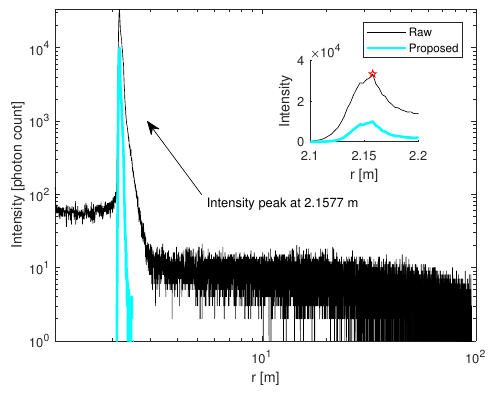
Figure 3. Short range detection results. Distribution of range observations r i from one channel, n = 127 , when sampling n over time in nominal conditions. Raw data from the single photon lidar (black) is filtered from outliers using the proposed technique (cyan). Target, i.e. an indoor wall, is detected near 2 . 1577 meters. The inset figure shows that the peak location is unchanged by the proposed